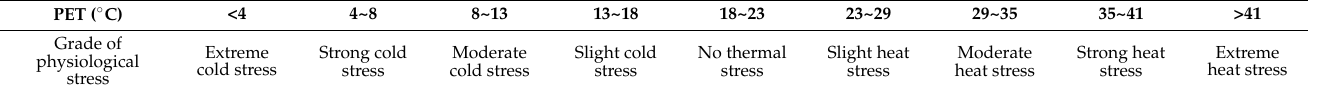
Table 3. PET range interpretation according to Matzarakis and Mayer